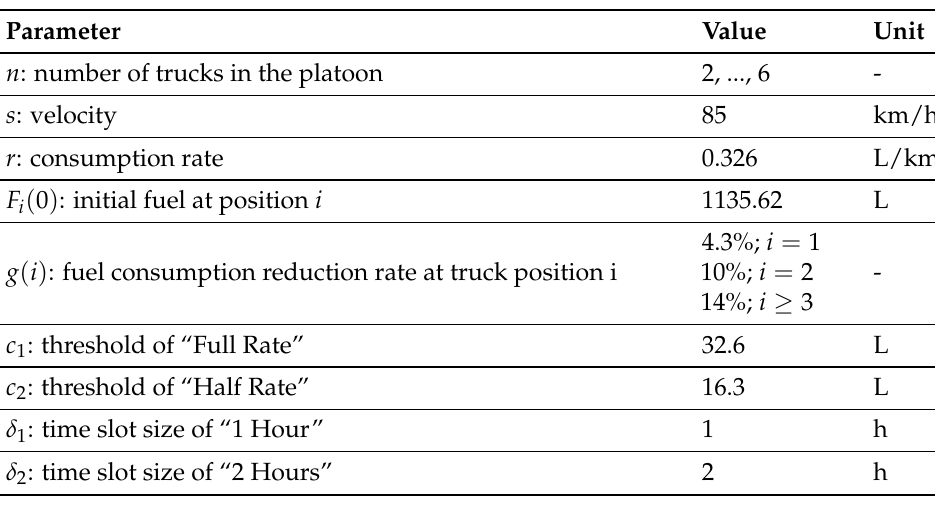
Table 4. Simulation